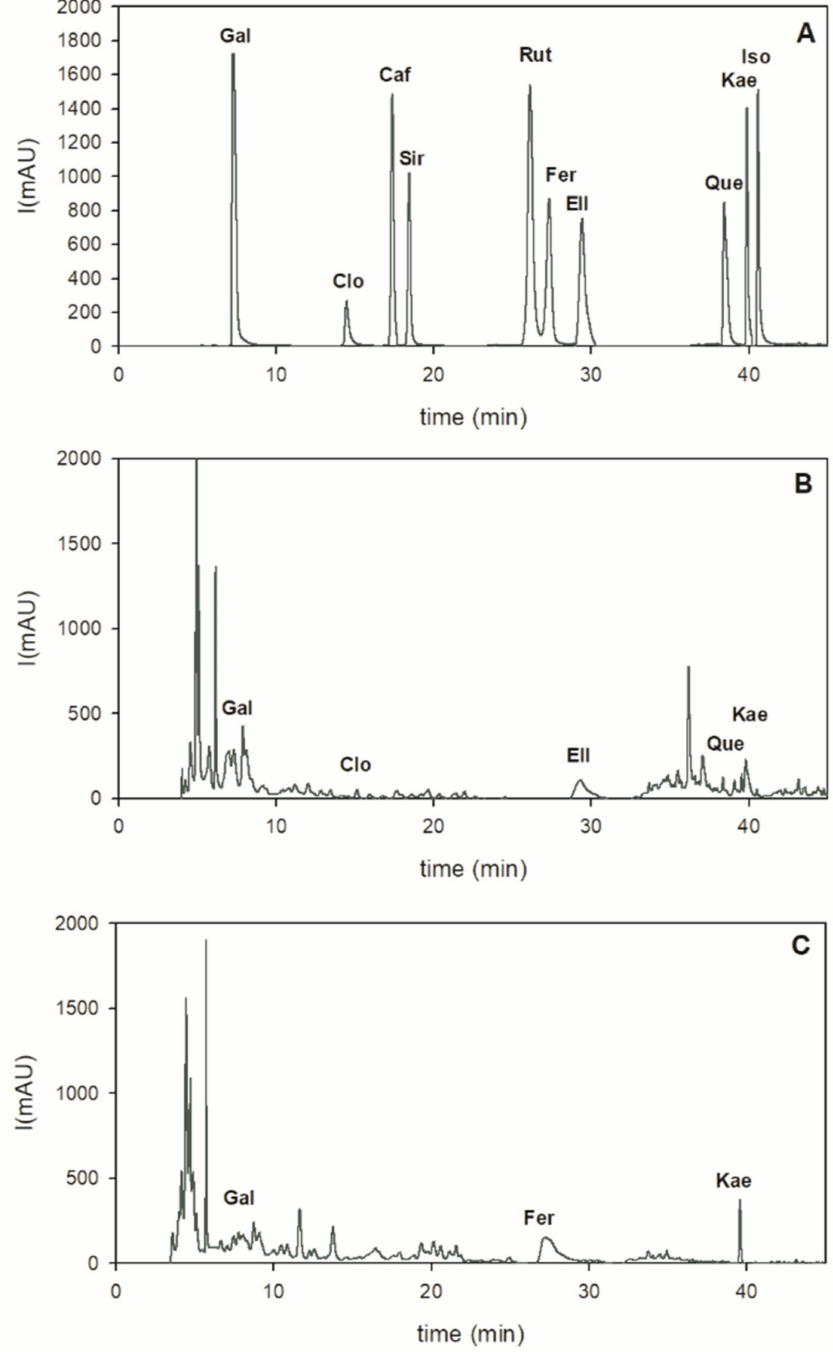
Figure 3. HPLC chromatograms of melon peel and seed extracts, monitored at 284 nm. ( A ) Standard mixture of bioactive compounds. ( B ) Melon peels ethanolic extract. ( C ) Melon seeds ethanolic extract. Gallic acid (Gal), Chlorogenic acid (Clo), Ca ff eic acid (Caf), Syringic acid (Sir), Rutin (Rut), Ferulic acid (Fer), Ellagic acid (Ell), Quercetin (Que), Kaempferol (Kae), Isorhamnetin